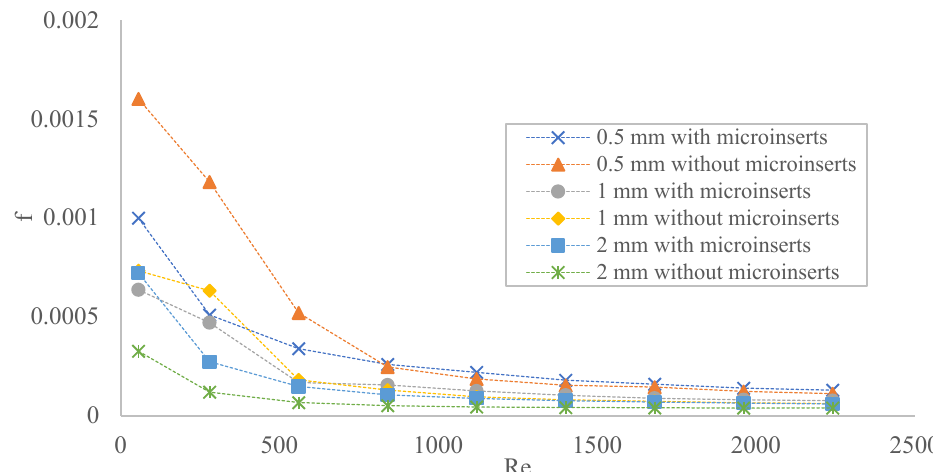
Figure 7. Friction factor variation as a function of Reynolds number.